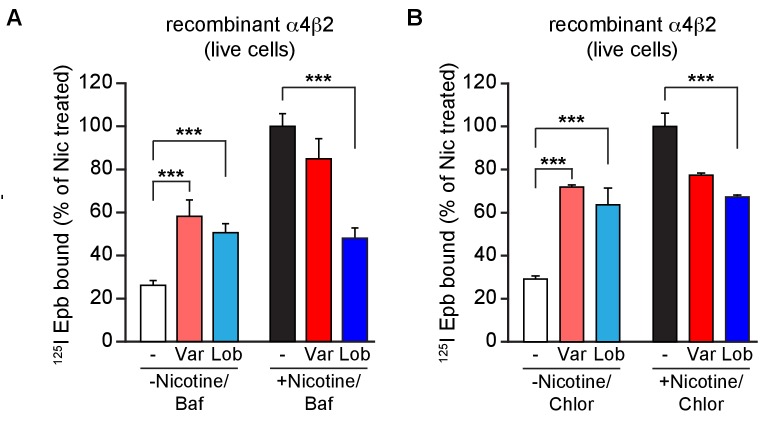
Altering intracellular pH of acidic vesicles alters the effects of varenicline and lobeline.(A) 125I-epibatidine binding on α4β2R-expressing HEK cells exposed to varenicline or lobeline 17 hr at 30 μM and then incubated twice (5 min each) with Bafilomycin A (50 nM), an inhibitor of vacuolar type H+ -ATPase (proton pump), prior to performing radio-ligand binding (n = 3). (B) 125I-epibatidine binding on α4β2R-expressing HEK cells exposed to varenicline or lobeline 17 hr at 30 μM and then incubated twice (5 min each) with a weak base chloroquine (150 μM) prior to performing radio-ligand binding (n = 3). In column graphs in A and B: ***p<0.001 by one-way ANOVA with Bonferroni’s multiple comparison test. n indicates number of independent experiments performed on separate days and cultures and error bars indicate mean ± s.e.m.